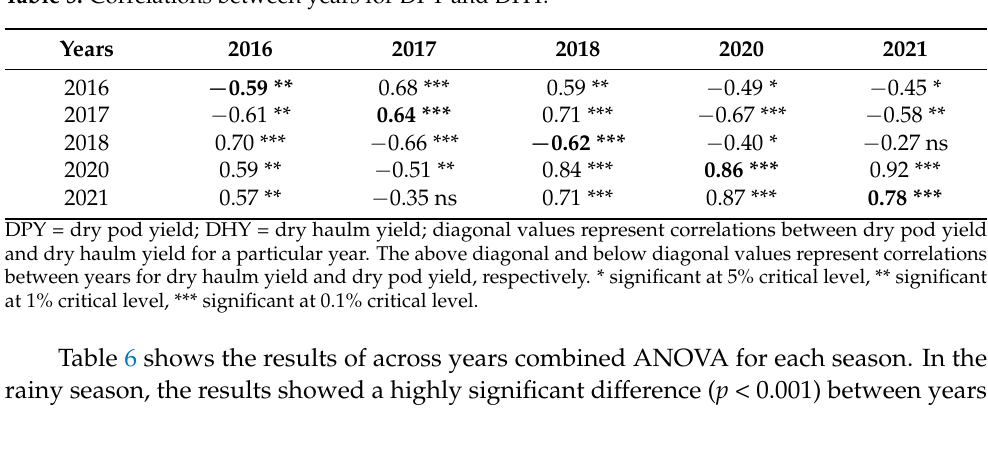
Table 5. Correlations between years for DPY and